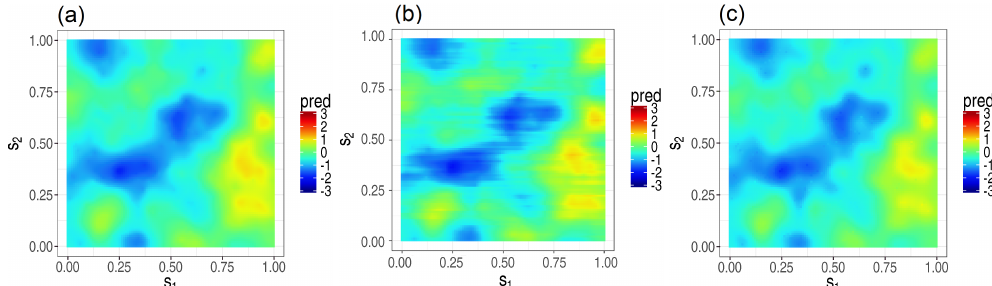
Figure 6. Spatial prediction of the true process (Figure 1b) using the experimental setup in Section 2.1 and data with increased measurement-error variance, σ 2 (cid:101) = 10. ( a ) Optimal prediction (pred) using the simulated retrievals; ( b ) the prediction (pred) from simple kriging on the prediction grid from the simulated retrievals using the exact model and a moving window in s 2 of width 0.1 units; ( c ) the prediction (pred) from fixed rank kriging on the prediction grid using the simulated